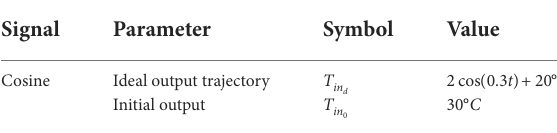
TABLE 3 Objectives of the tracking squarewave and ramp